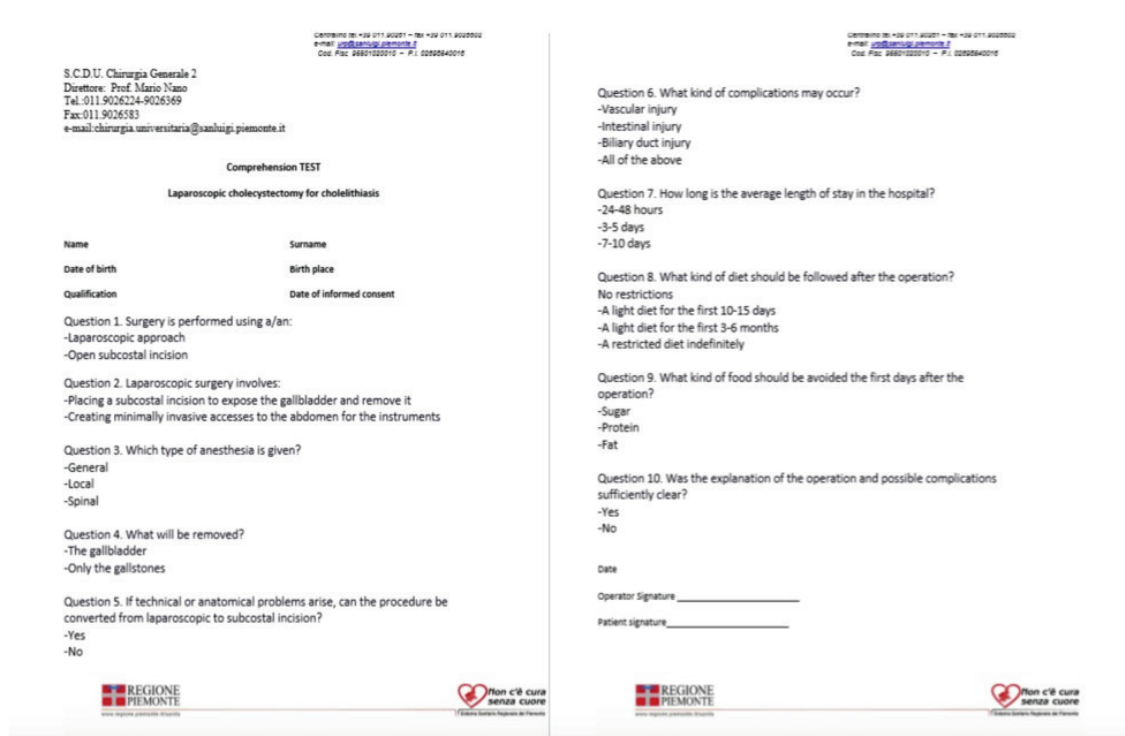
Figure 2: Feedback